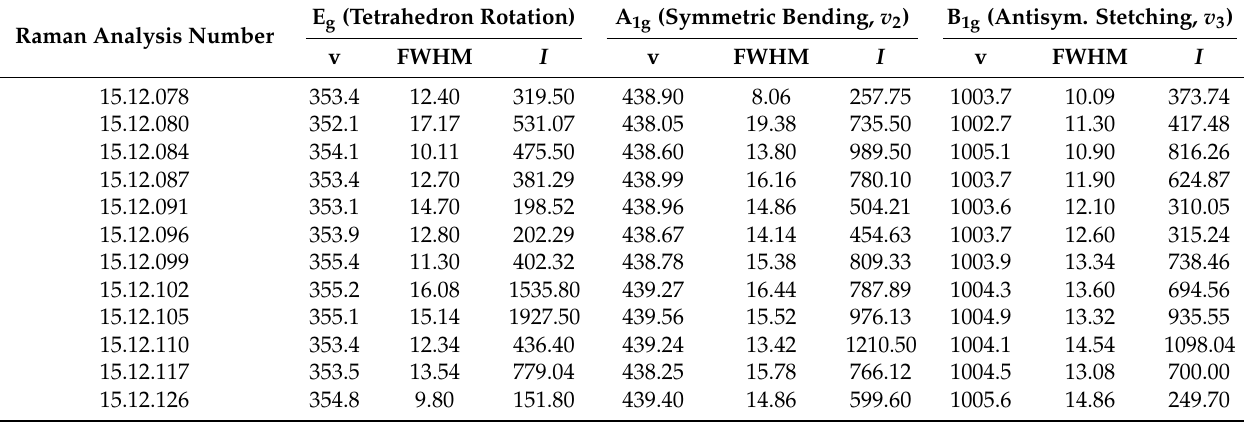
Table A5. Parameters of the Raman bands of representative zircon grains from the studied chromitites, where v is in cm − 1 and I is in counts.